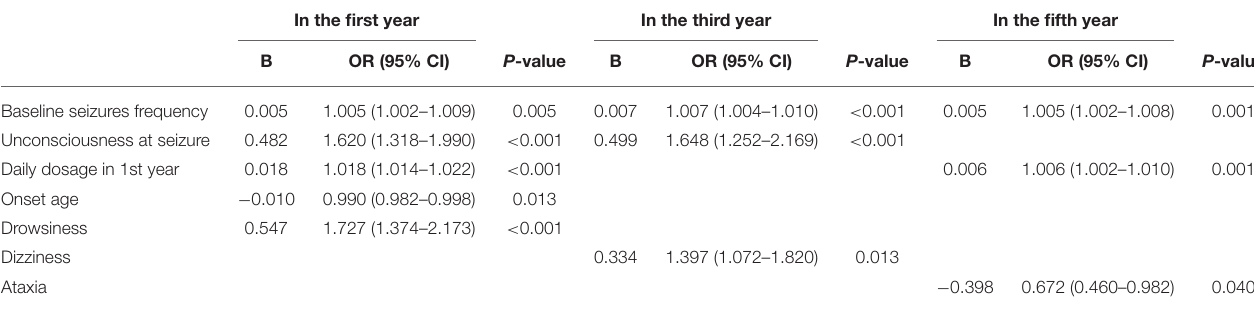
TABLE 4 | Multivariate logistic regression analysis to explore the predictive factors of non-seizure-free at different stages of follow-up. In the first year In the third year In the fifth